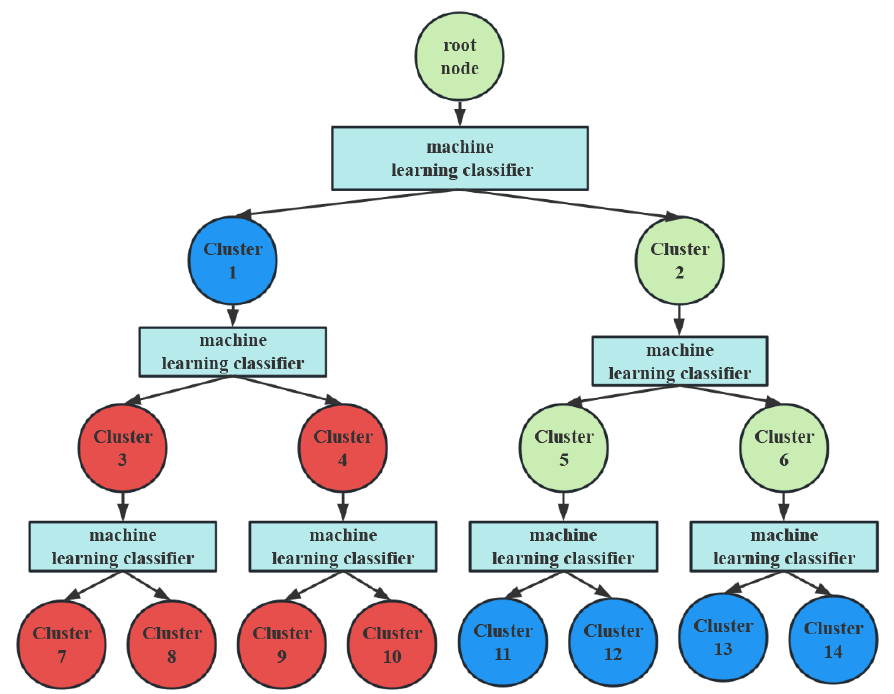
Figure 6. An example of classification tree with